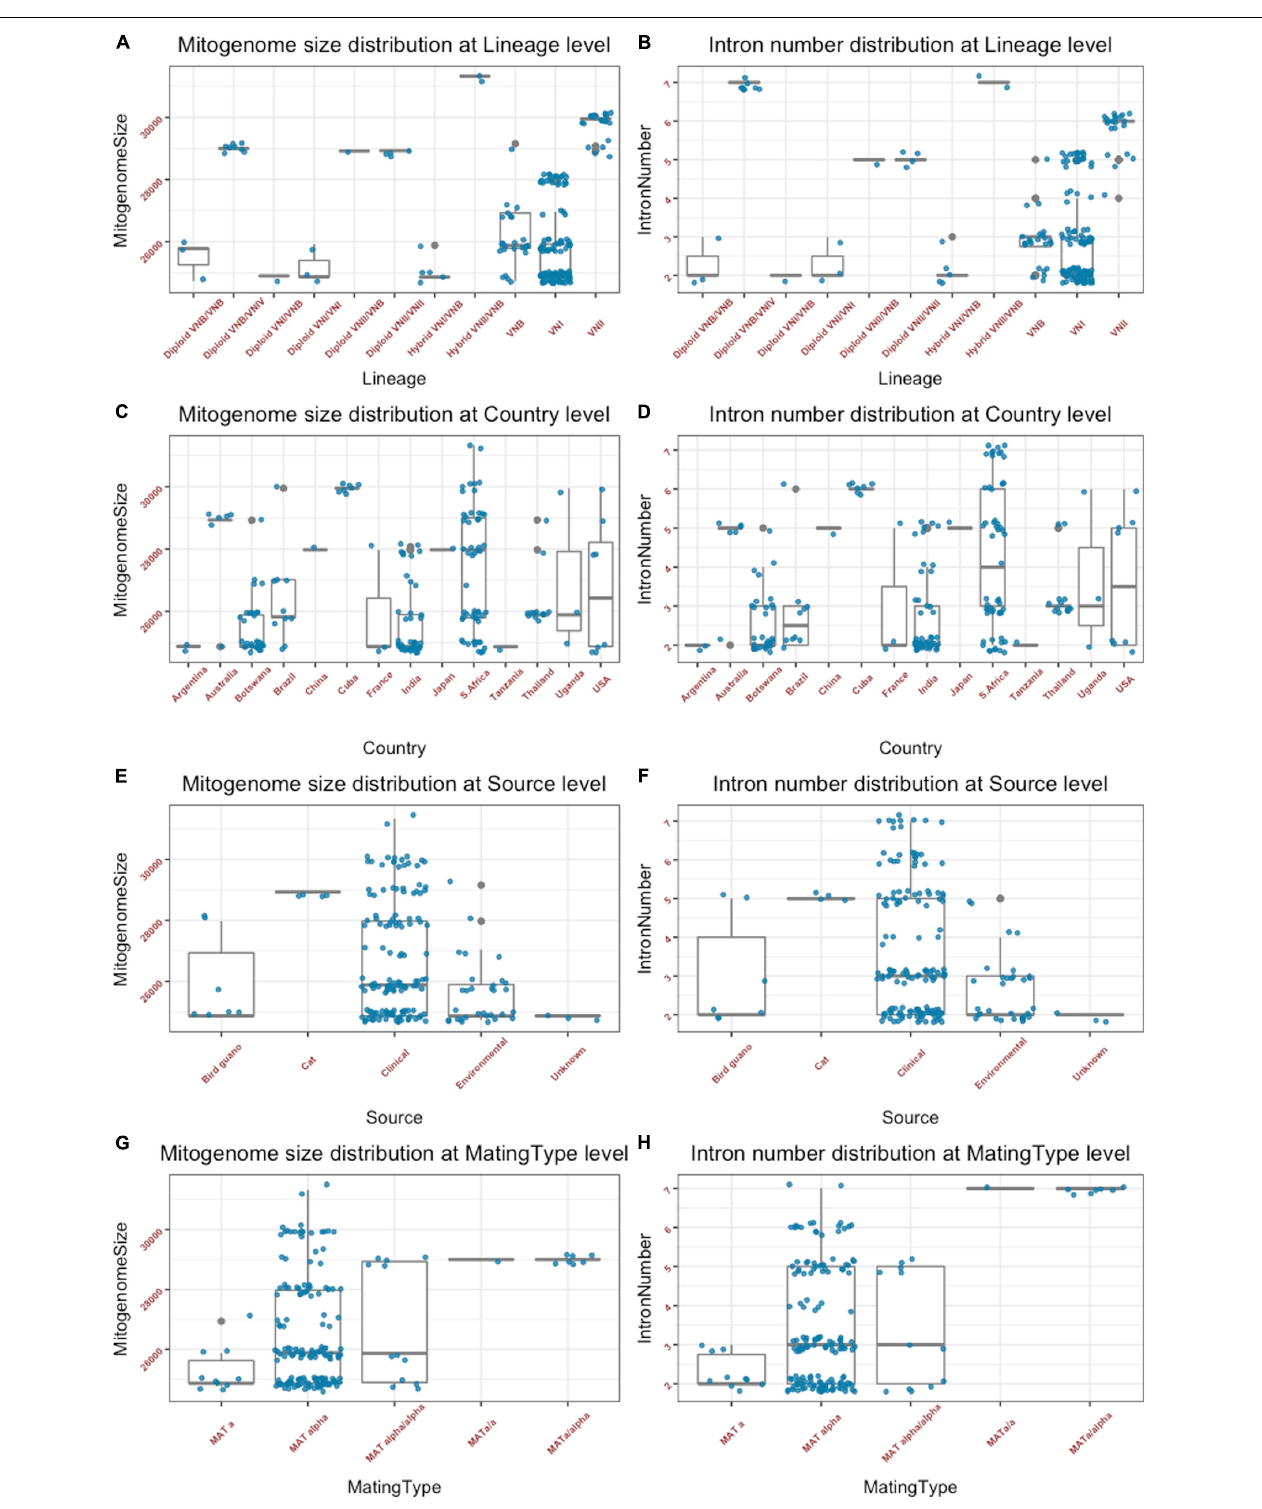
FIGURE 2 | Mitogenome sizes and intron numbers distribution among strain features as defined based on various characteristics. (A,B) Variations within and among clades and genotype groups as defined based on nuclear genome SNPs. (C,D) variations within and among their geographic (country) origins. (E,F) Variations within and among ecological niches. (G,H) Variations within and among different mating types or mating type combinations. Random noise was added to plots using a uniform distribution with 0.38 horizontal jitter. The vertical jitter was set as 200 bp for genome size and 0.2 for intron number.